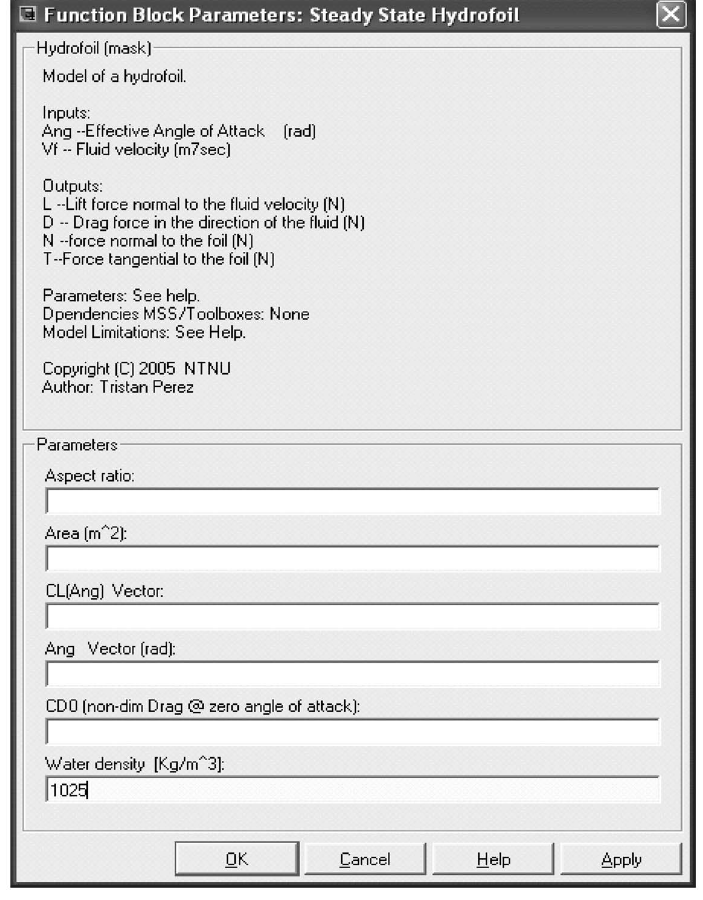
Figure 7. Example of dialog